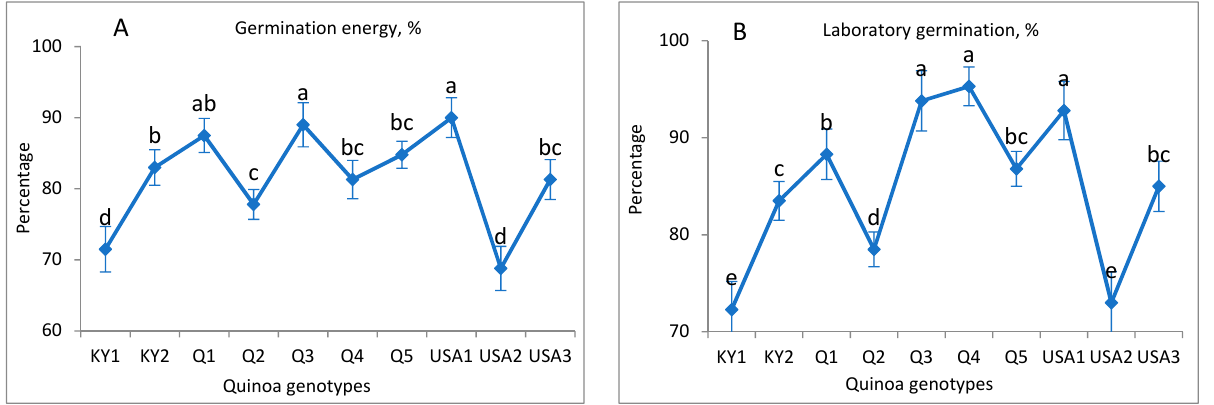
Figure 4. Germination energy and laboratory germination of quinoa seeds genotypes. ( A ) Germination energy percentages; ( B ) laboratory germination percentages. The same letter(s) statistically not different ( p < 0.05).